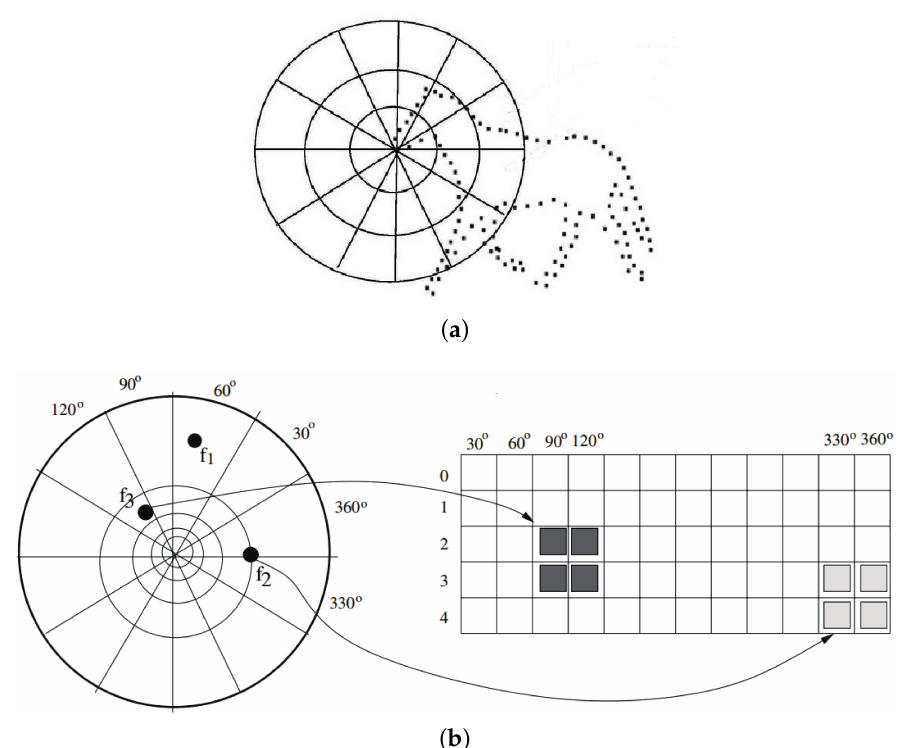
Figure 5. Shape context examples. ( a ) Log-polar coordinates in shape context; ( b ) Shape Context Encoding.